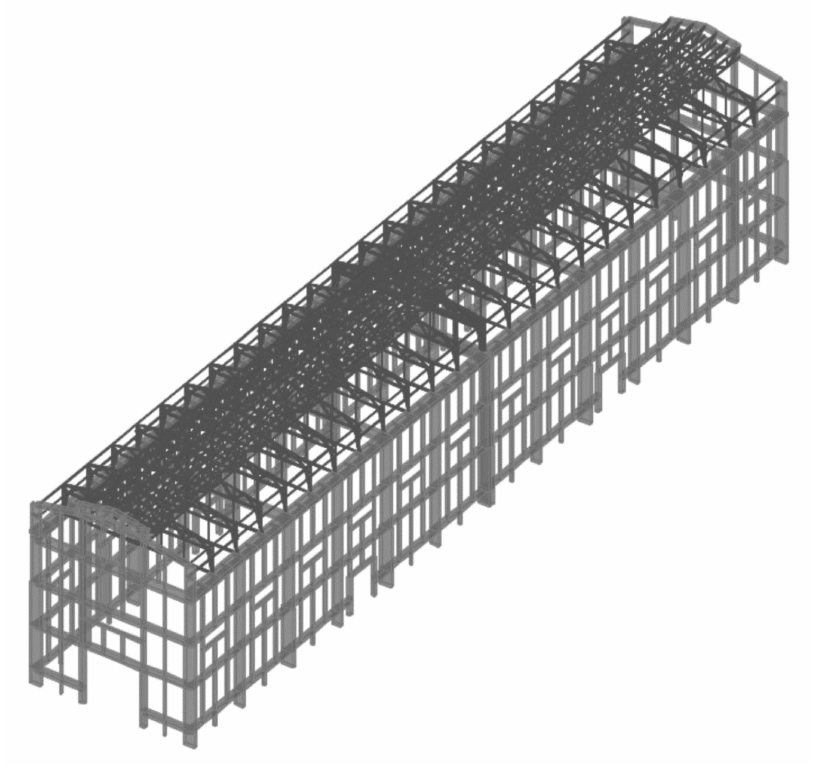
Figure 4. FEM model of the